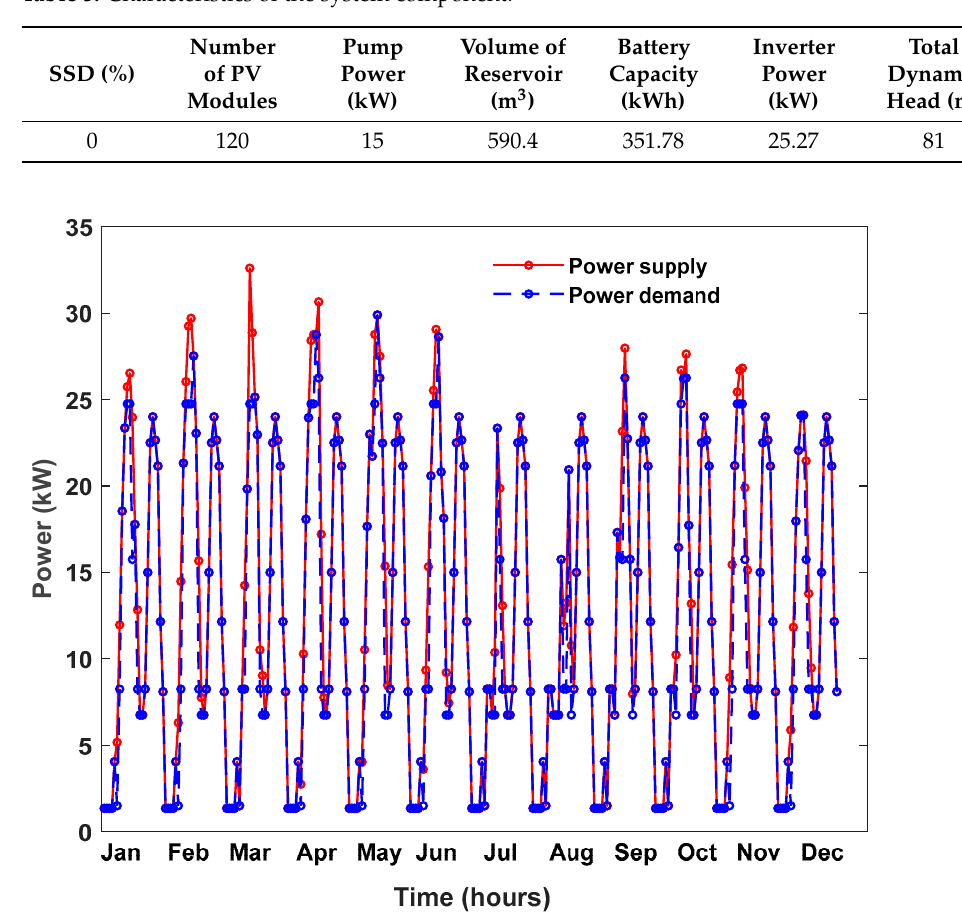
Figure 15. The comparison between the total power supply and the total power demand at any time of the year for the PV-system-based battery energy storage.